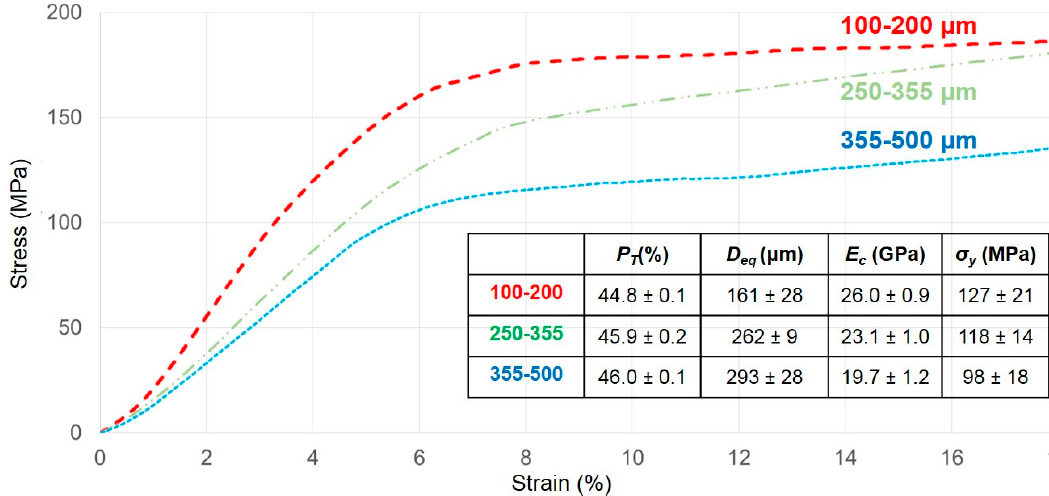
Figure 4. Stress–strain curve of the three porous titanium substrates. Inset: Parameters obtained from Archimedes’ method ( P T and D eq ) and uniaxial compression test (Young’s modulus ( E c ) and yield strength ( σ y )).